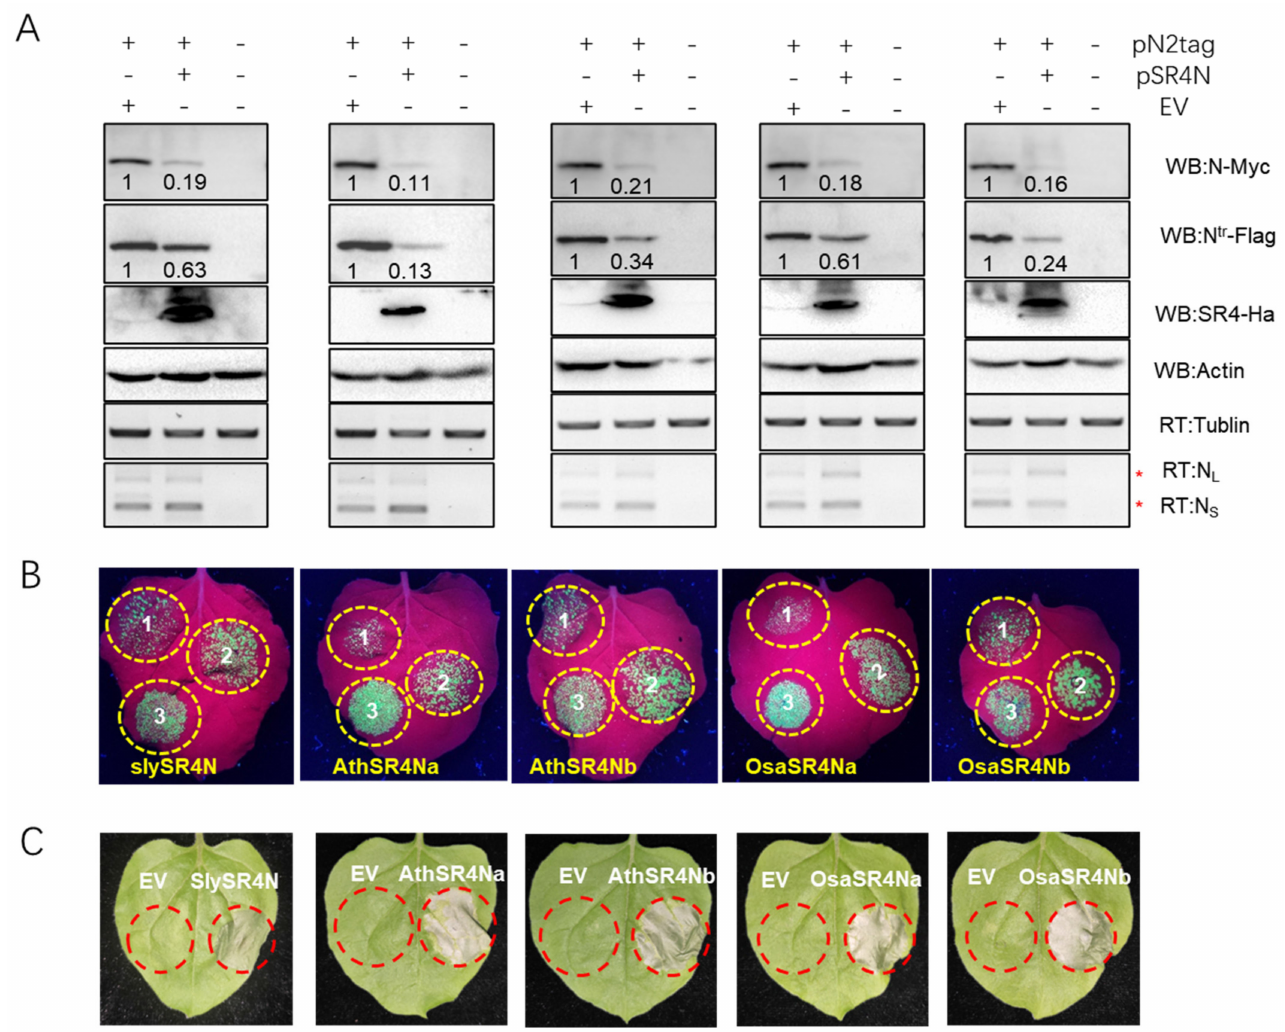
Figure 6. SR4N functions are conserved in homologs from different plant species. ( A ) Impact of tomato, Arabidopsis, and rice SR4N on N protein and transcript accumulation. Co-expressed constructs are indicated on top of each lane. The SR4Ns expressed from the left to the right are SlySR4N, AthSR4Na, AthSR4Nb, OsaSR4Na, and OsaSR4Nb. Top four rows are Western blots, with target proteins indicated to the right. Bottom two rows are RT-PCR gels, with target transcripts indicated to the right. Red stars * mark the N L and N S isoforms. ( B ) Green florescence imaging of leaves in co-infiltration experiments. Yellow circles mark the infiltrated patches. Circle 1 is co-infiltrated with TMV-GFP and N; circle 2, TMV-GFP and EV; circle 3, TMV-GFP, N, and SR4N, indicated at the bottom. ( C ) Cell death triggered by SR4Ns from different plant species. Red circles mark the infiltrated patches, with vectors indicated